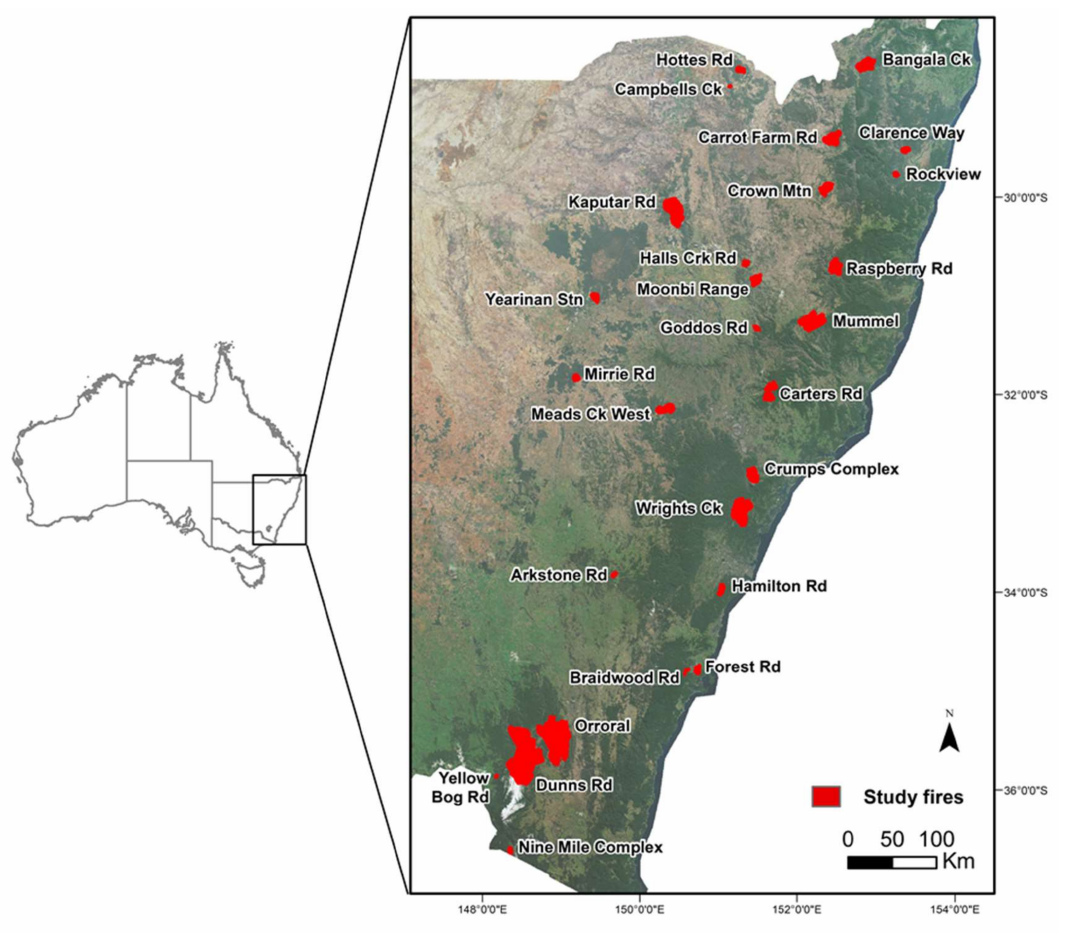
Figure 1. Location and relative size of the 27 study fires used to compare fire extent and severity map outputs in New South Wales,